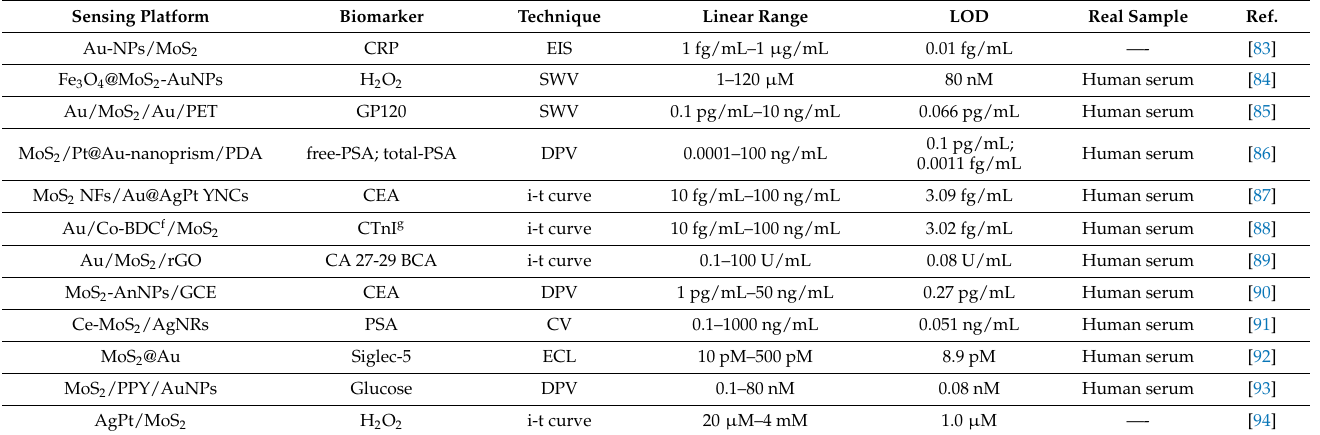
Table 2. Literature reports on the analytical parameters of MoS 2 conjugated nanoparticles for various biomarker